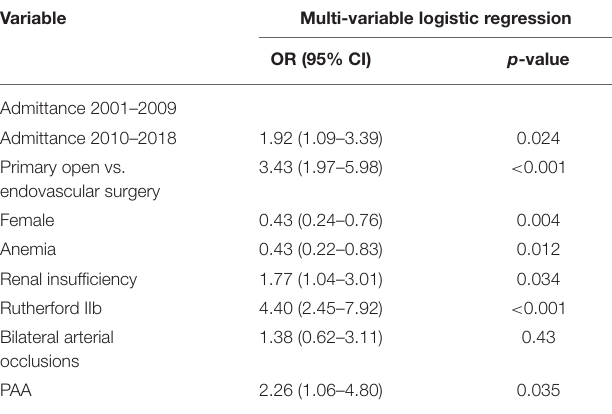
TABLE 5 | Factors associated with fasciotomy after revascularization for ALI.